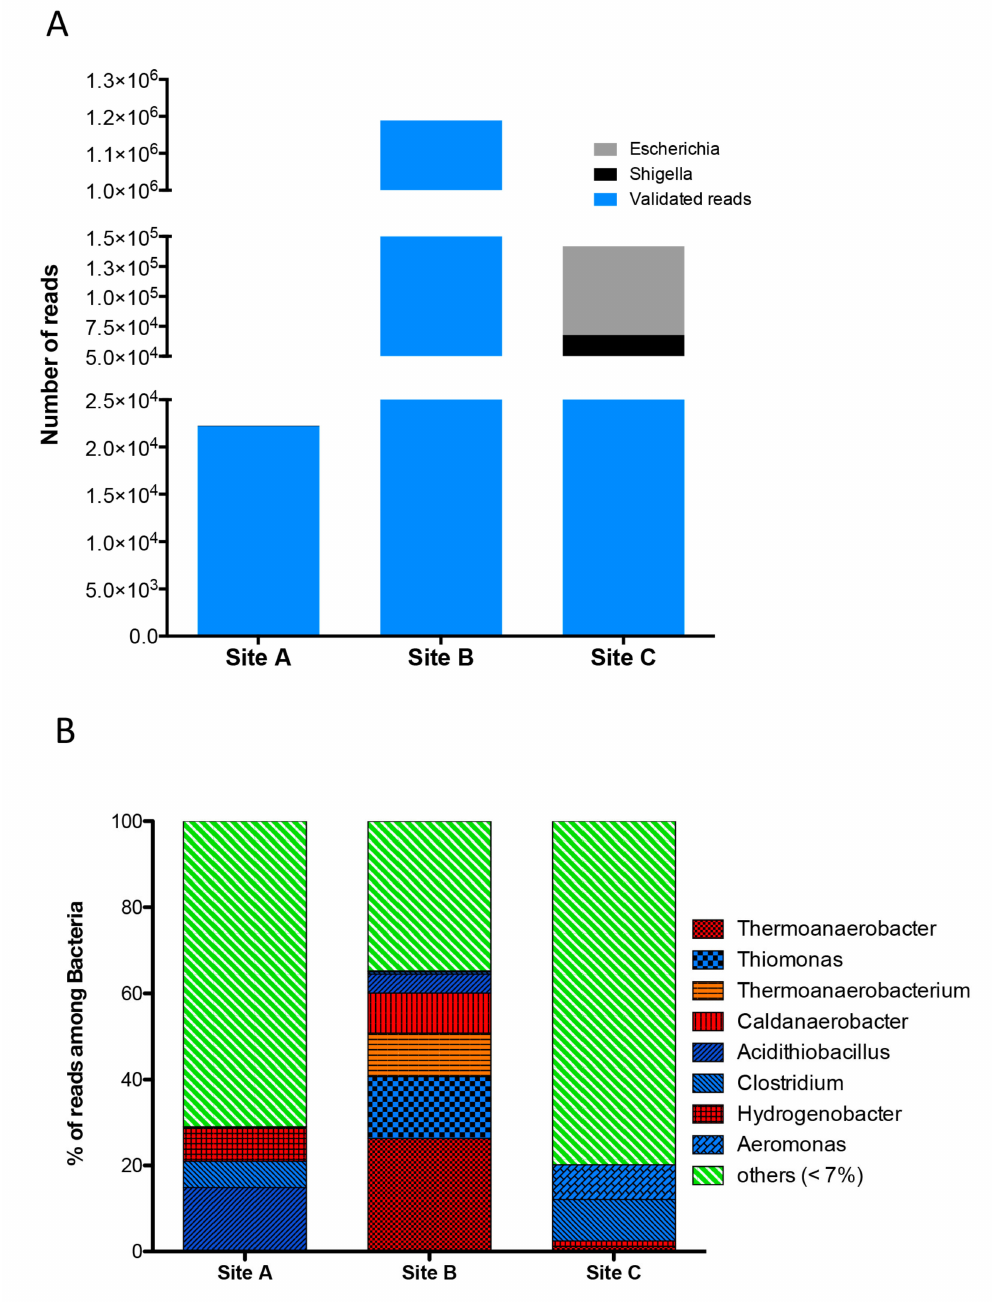
Figure 5. ( A ) Number of reads in Sites A, B, and C assigned to bacteria. Black and grey indicate the reads assigned to the genera Shigella and Escherichia , respectively, and filtered as contaminants. In blue the number of validated reads used for the bacteria community analysis. ( B ) Bacteria community profile, relative abundances, and diversity: hyperthermophiles (red), thermophiles (orange), mesophiles (blue), others (each relative abundance % < 7,